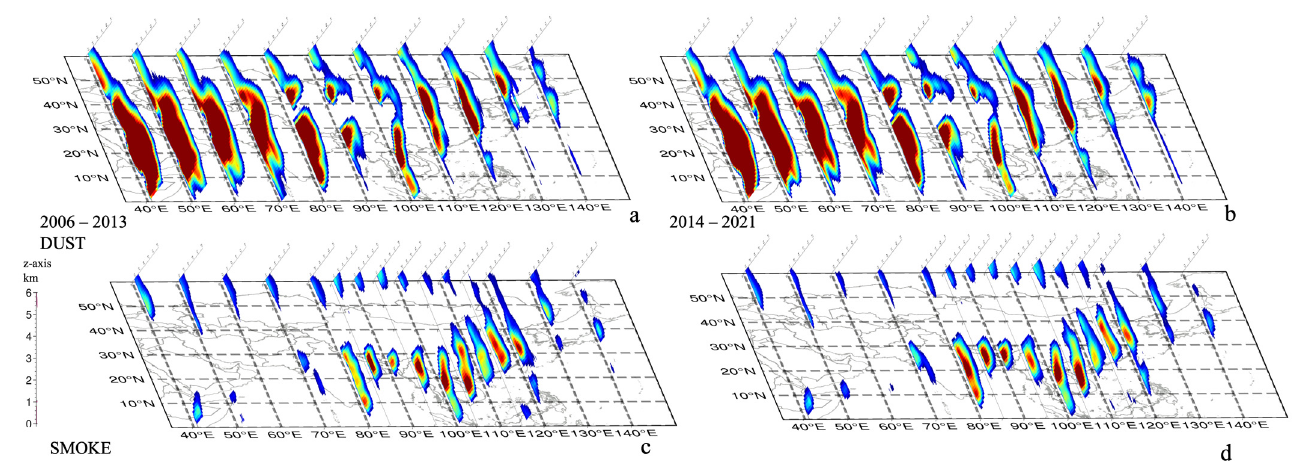
Figure 5. Averaged latitude–vertical 3D aerosol FoO (>5%) derived from level-2 CALIOP VFM products during two periods, 2006–2013 and 2014–2021, along longitudes from 40 ◦ E to 140 ◦ E (the interval is 5 or 10 degrees). ( a ) DUST FoO from 2006 to 2013; ( b ) DUST FoO from 2014 to 2021; ( c ) SMOKE FoO from 2006 to 2013; ( d ) SMOKE from 2014 to 2021.